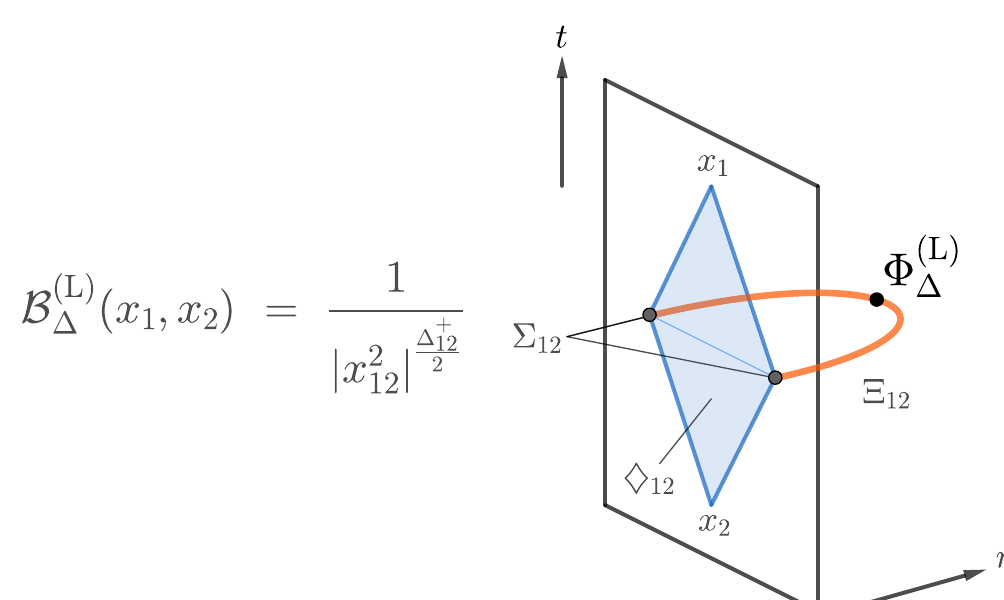
Figure 7 . Time-like OPE block and surface Witten diagram. The blue shaded region is the causal diamond } 12 of the time-like separated points x 1 and x 2 . The co-dimension-two surface (cid:6) 12 , which is the intersection of the past lightcone of x 1 and the future lightcone of x 2 , is represented by two points in the (cid:12)gure. The bulk (cid:12)eld is smeared over the codimension-two surface (the orange curve) in the